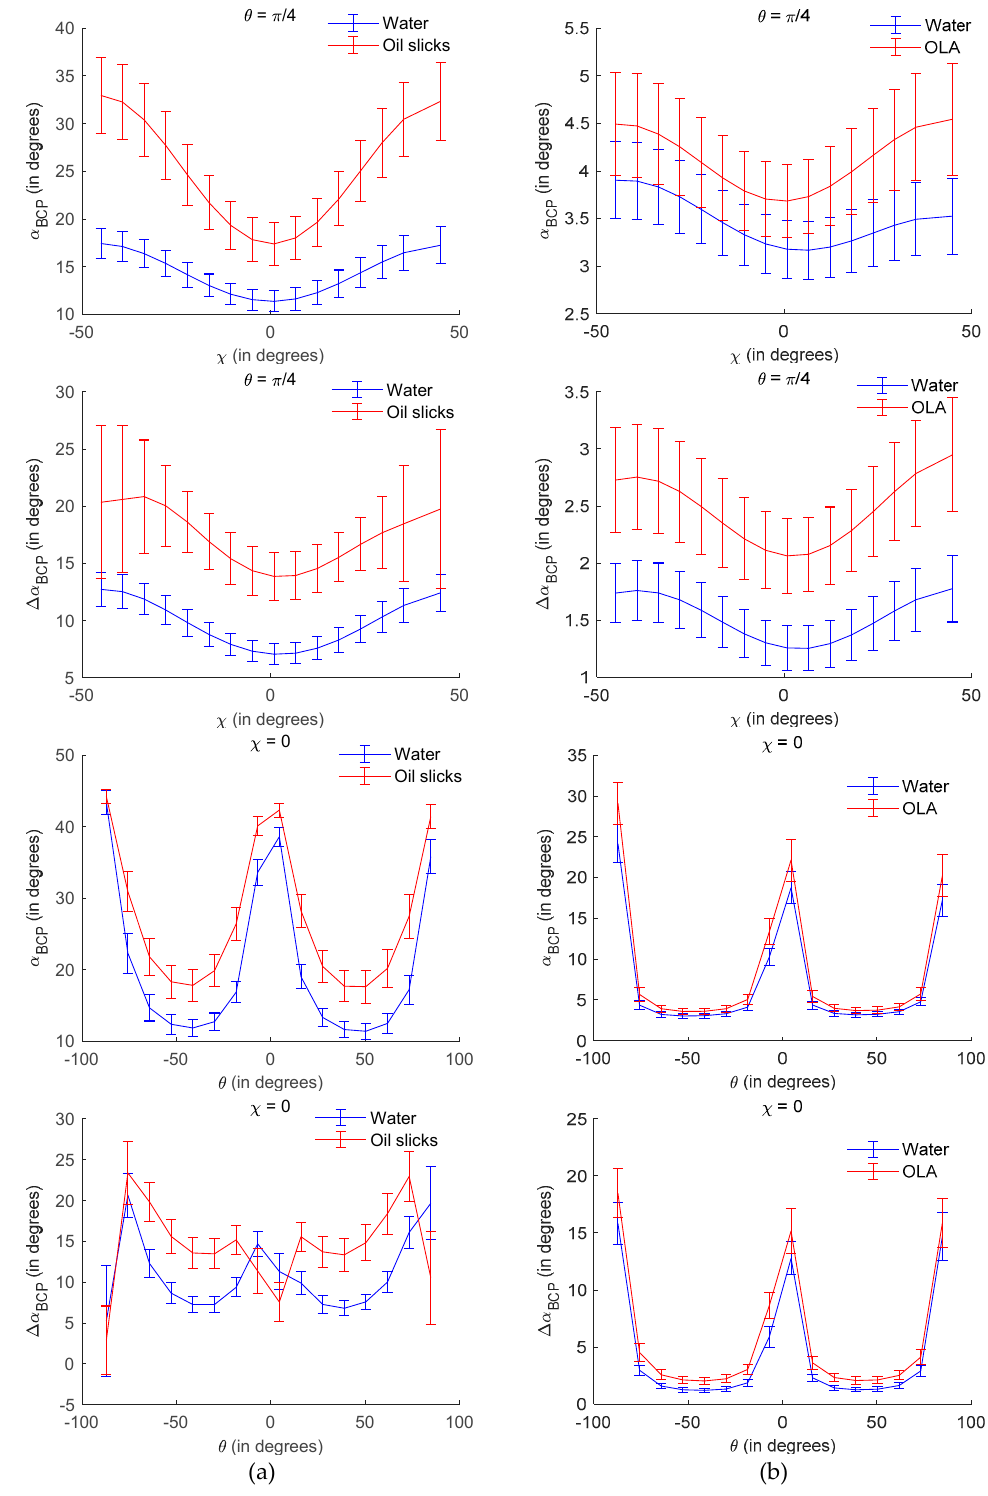
Figure 7 . Variation of 𝛼 (cid:2886)(cid:2887)(cid:2900) and ∆𝛼 (cid:2886)(cid:2887)(cid:2900) values with varying transmitted wave polarizations for the Figure 7. Variation of α BCP and ∆ α BCP values with varying transmitted wave polarizations for the water surface, oil slick, and OLA areas outlined in Figure 5. (a) SIR-C data with p.n. 49939. (b) SIR-C water surface, oil slick, and OLA areas outlined in Figure 5. ( a ) SIR-C data with p.n. 49939. ( b ) SIR-C data with p.n. 41370. data with p.n.